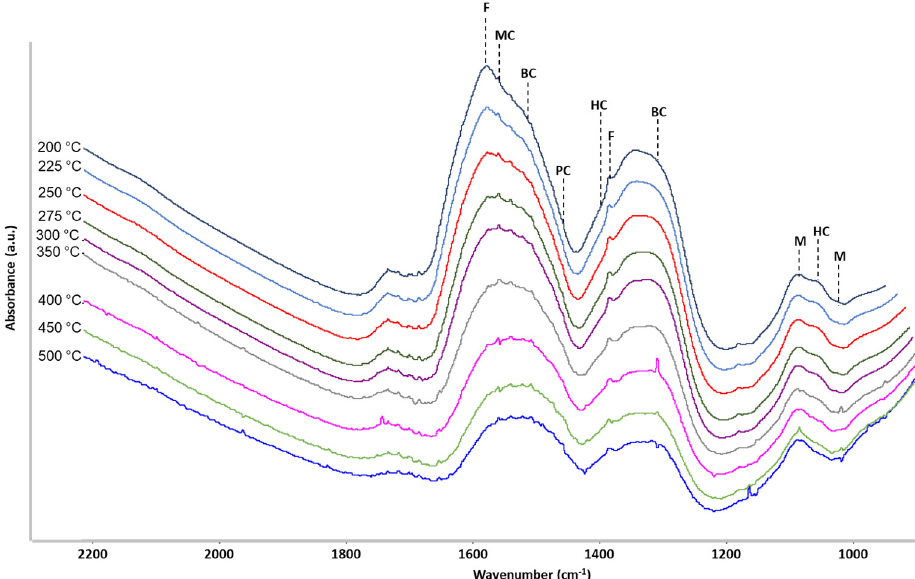
Figure 9. Operando FTIR spectra for CO 2 methanation over the Ni/ZrCe catalyst. Species identification: HC (hydrogen carbonate), MC (monodentate carbonate), BC (bidentate carbonate), PC (polydentate carbonate), F (formate), M (methoxy), FO (formaldehyde), and C (carboxylate).